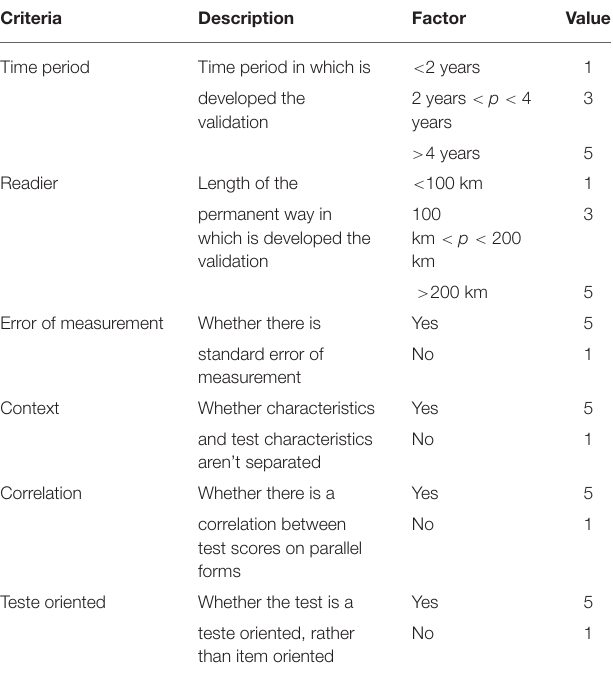
TABLE 2 | Criteria of assessment to the complexity of the validation.